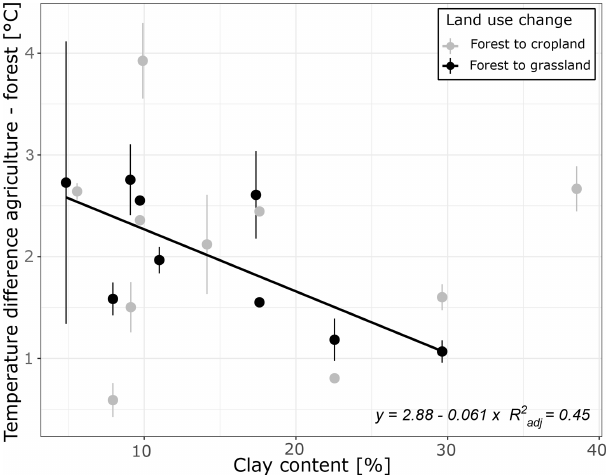
Figure 4. Relationship between clay content [%] and soil tempera- ture difference between agricultural land and forest. Points indicate mean values between 10 and 50cm depth; vertical lines indicate standard deviation of the mean temperature between 10 and 50cm. The thick line (black) and the formula show the linear regression for the given relationship for the conversion from forest to grass- land ( p< 0 . 05).